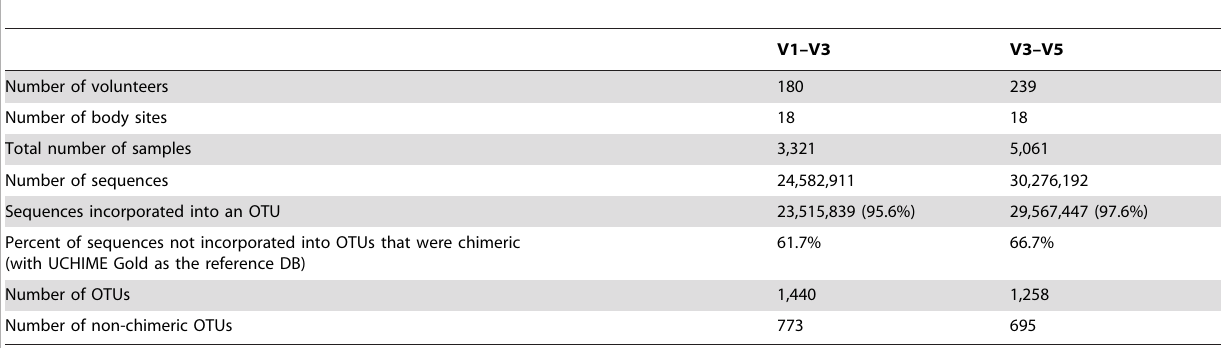
Table 1. Number of samples and sequences included in the V1–V3 and V3–V5 analysis.